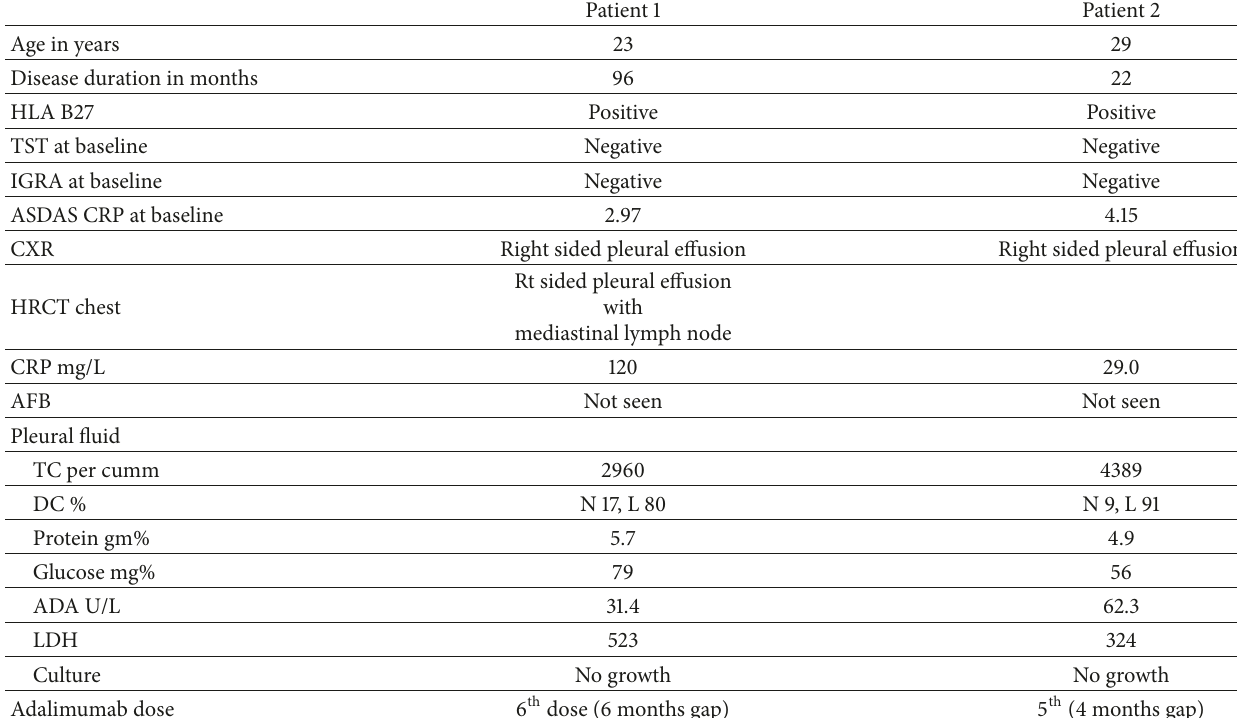
Table 4: Characteristics of patients developing tubercular pleural effusion